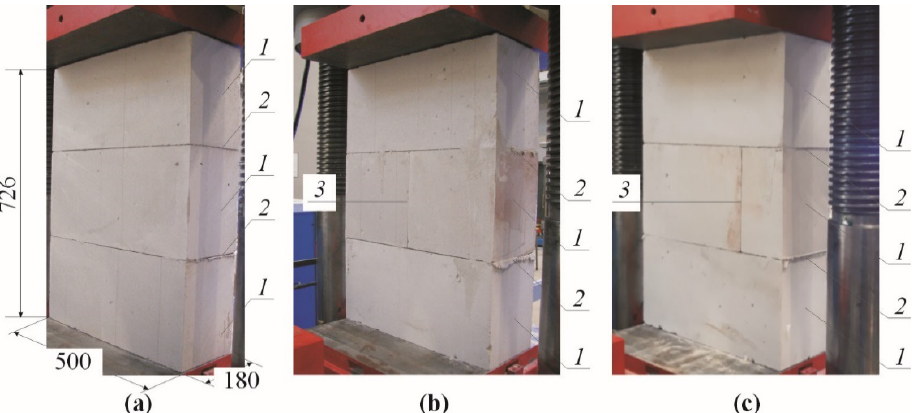
Figure 12. Geometry of models made of AAC tested in stage II: ( a ) models of series I without head joint, ( b ) models of series II with head joint at mid-length of the masonry unit, ( c ) models of series III with head joint at 1/4 length of the masonry unit; 1—masonry units, 2—bed joints, 3—head